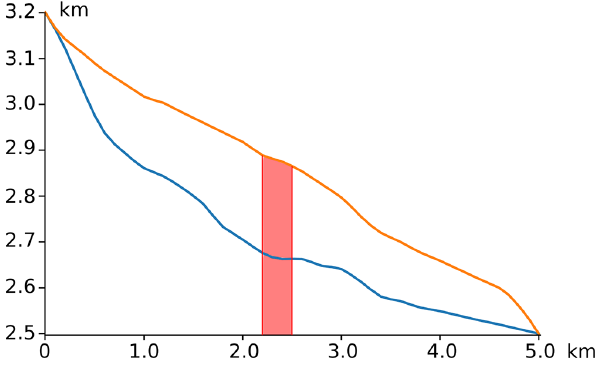
Figure 3. Longitudinal profile of Haut Glacier d’Arolla (Pattyn et al., 2008). Blue line: contact ice–rock. Orange line: contact ice–air. Red zone: area of varying basal conditions, with either β 2 = ∞ or β 2 =